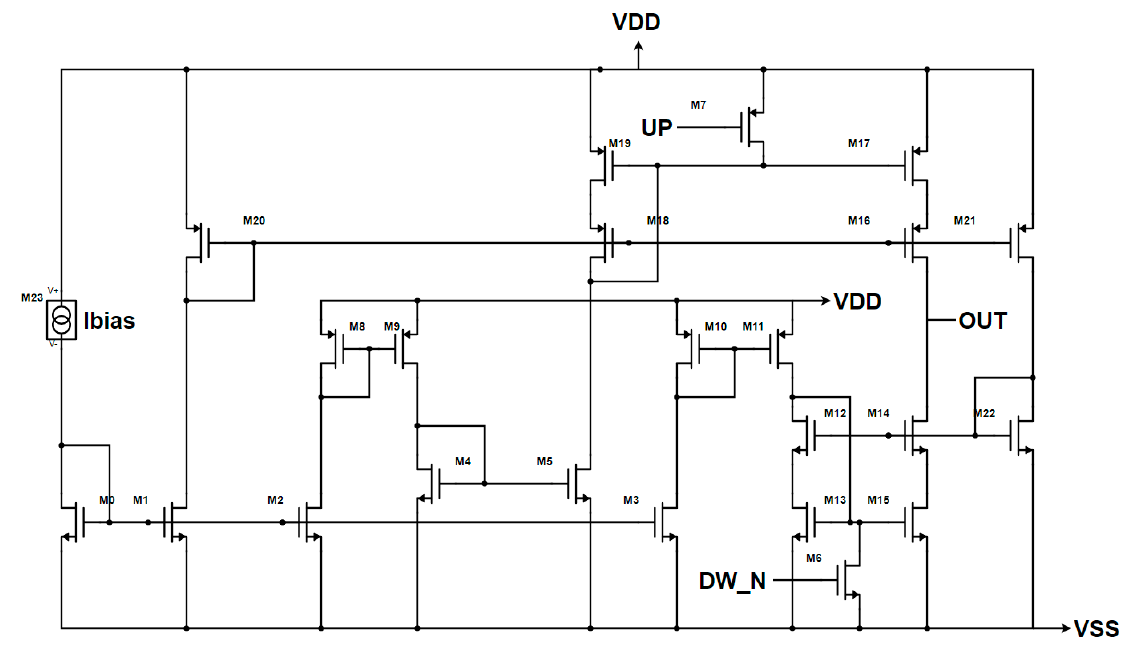
Figure 9. Enhanced CP’s Gate Switching architecture with CMOS standard inputs.